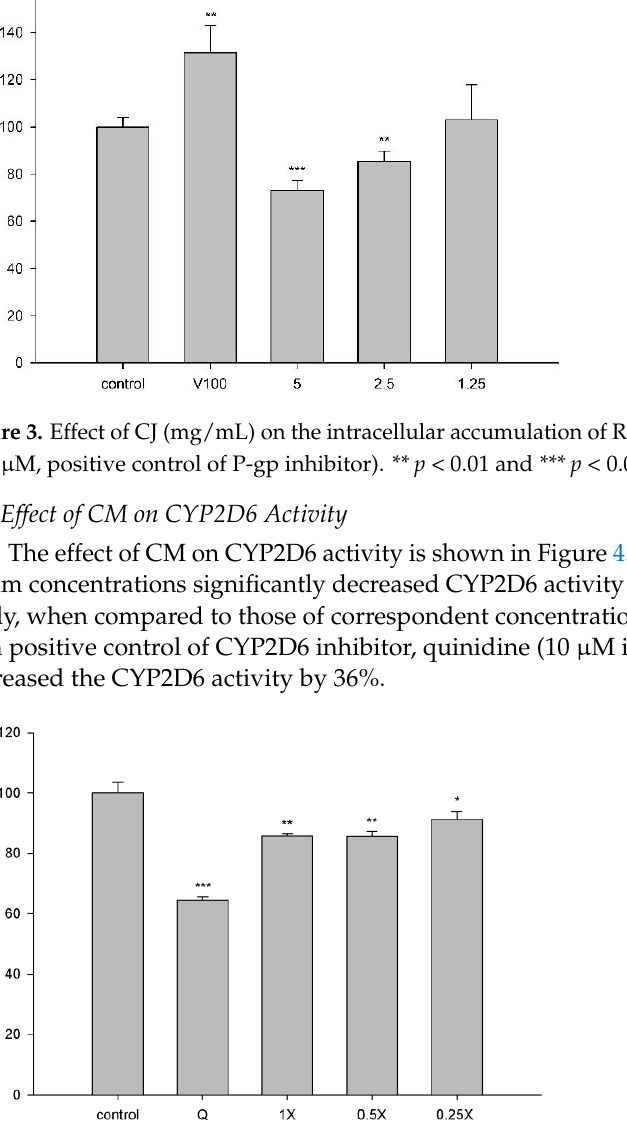
Figure 4. Effects of CM (1-, 0.5- and 0.25-fold serum concentration) on the activity of CYP2D6. Q: quinidine (10 μM in blank serum, positive control of CYP2D6 inhibitor). * p < 0.05, ** p < 0.01 and *** p < 0.001.